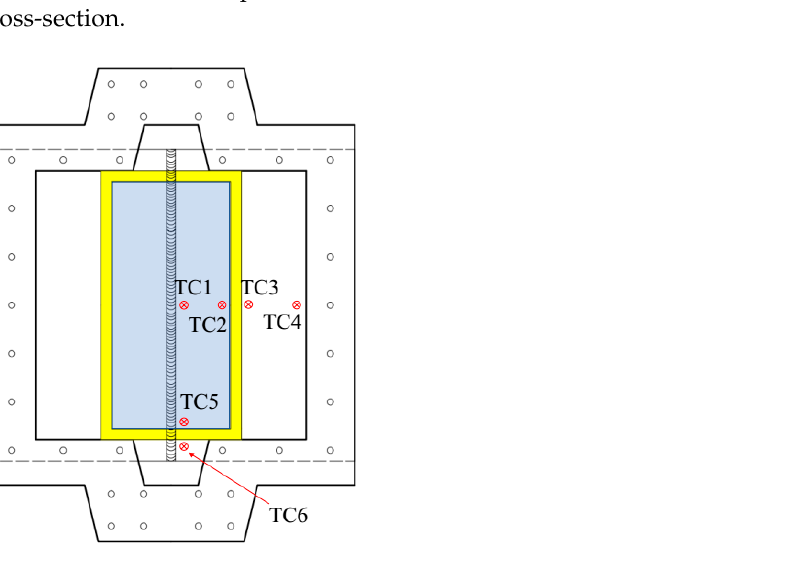
Figure 4. Arrangement and layout of the thermocouples at each measurement point.